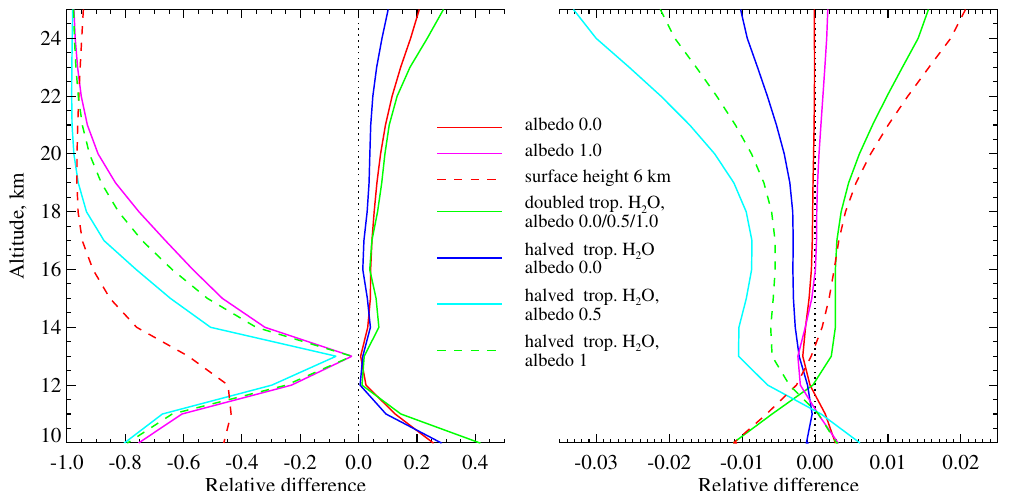
Fig. 10. Relative retrieval errors due to unknown atmospheric or surface parameters considering (right panel) and neglecting (left panel) the underlying scene in the retrieval process. See text for